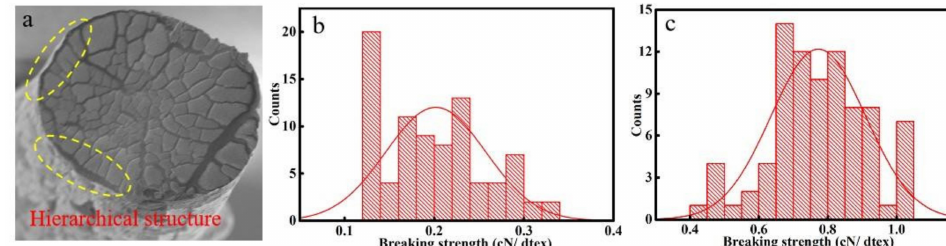
Figure 9. ( a ) SEM images of the hierarchical structure in the alginate fiber, Breaking strength of alginate fiber with the hierarchical structure ( b ) and without the hierarchical structure ( c ).